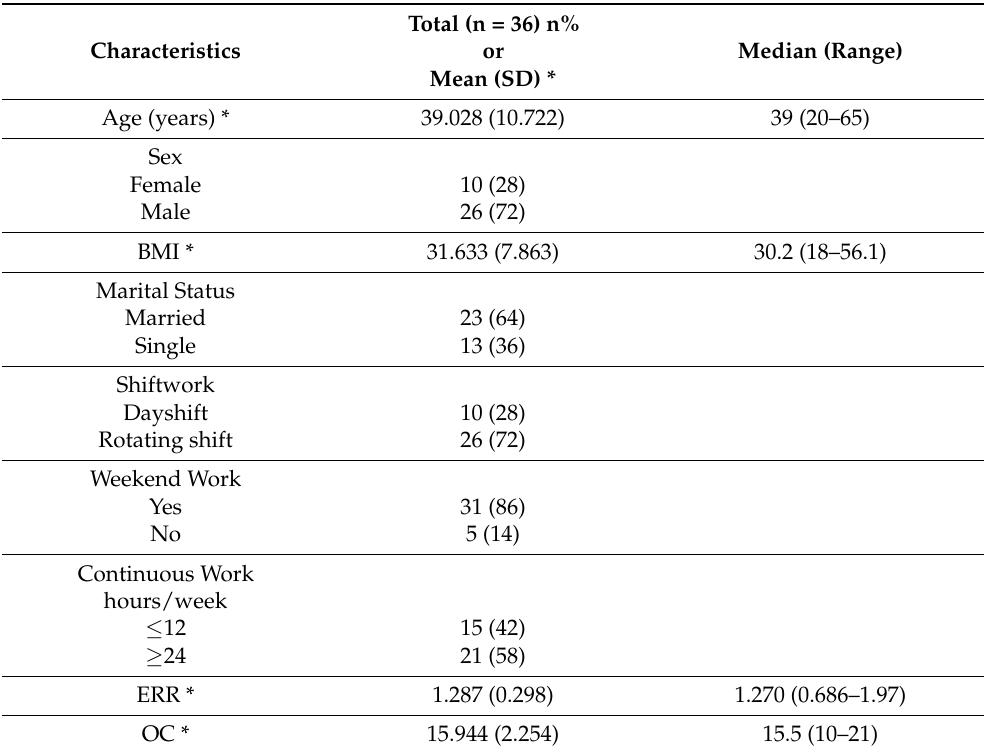
Table 1. Descriptive statistics of the study participants.